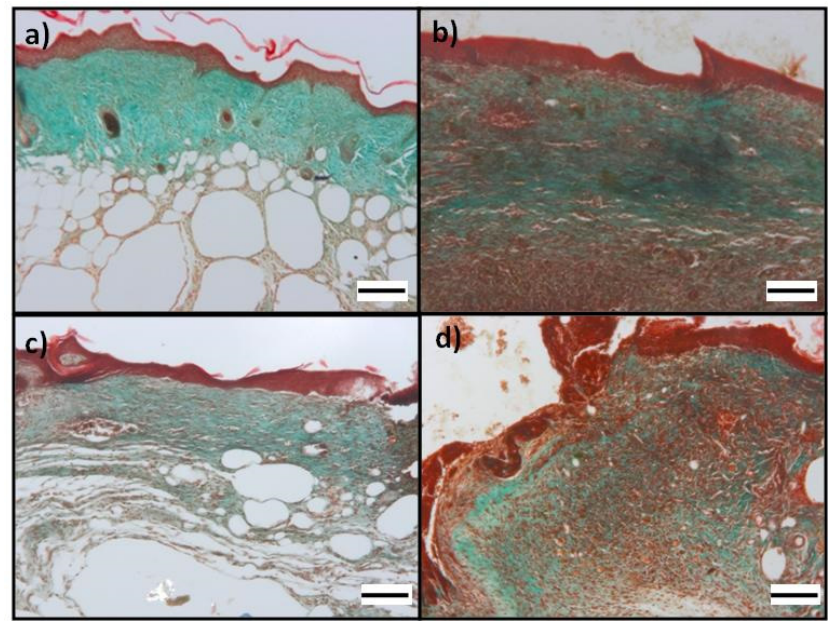
Figure 8. Photomicrographs of wound at day 14: Masson’s trichrome for evaluation of collagen in histological sections of excisional wound site obtained from a diabetic wound: ( a ) and ( b ) images from different mice treated Plg-loaded fibrin scaffold show a qualitative greater collagen deposition compared to ( c ) and ( d ) images from different mice treated with Plg-unloaded fibrin scaffold. Collagen fibers stained with light green SF yellowish appear green. All figures show epithelialization and granulation tissue based on the state of wound healing; OM 100× (scale bare = 100 μ m).